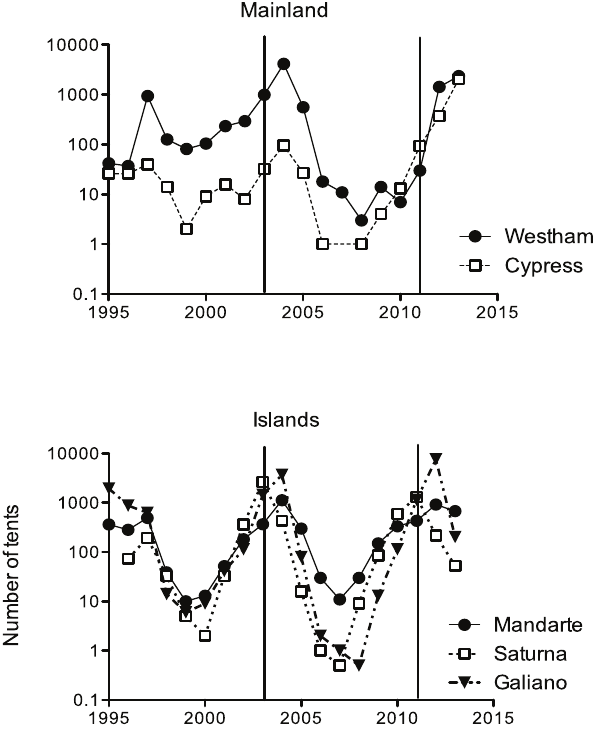
Figure 2. Population trends for western tent caterpillars on three southern Gulf Islands and one mainland site. The Pender Island population was not counted but was observed to be high in 2003 and 2011. Vertical lines indicate the years that were sampled for genetic